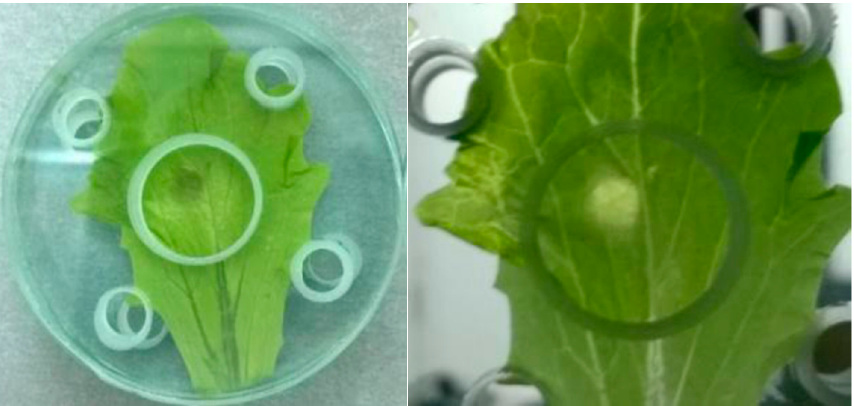
Figure 2. Example of visible plasma-induced damage.